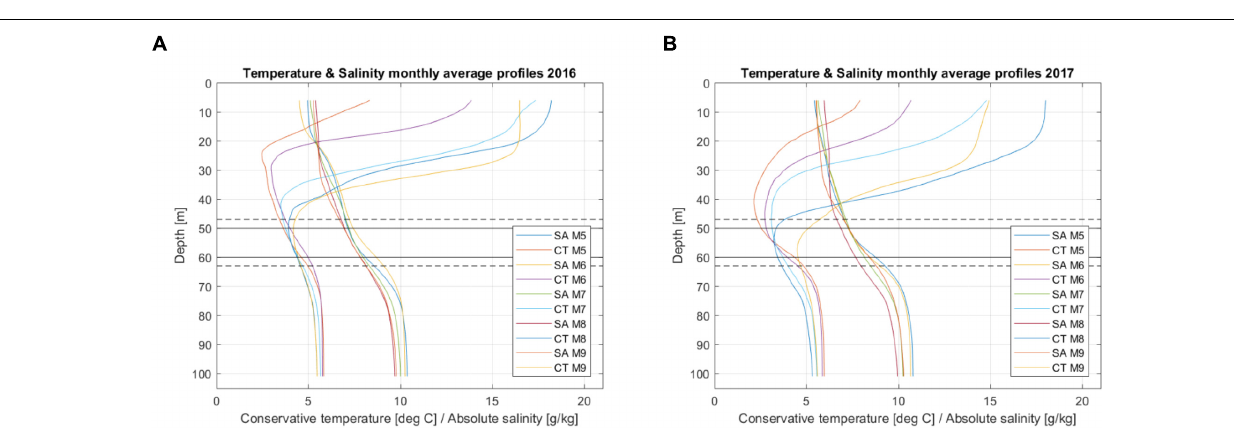
a monthly scale, the diffusion had the lowest contribution with the values varying in the range from 0 to − 0.4 mg · l − 1 · month − 1